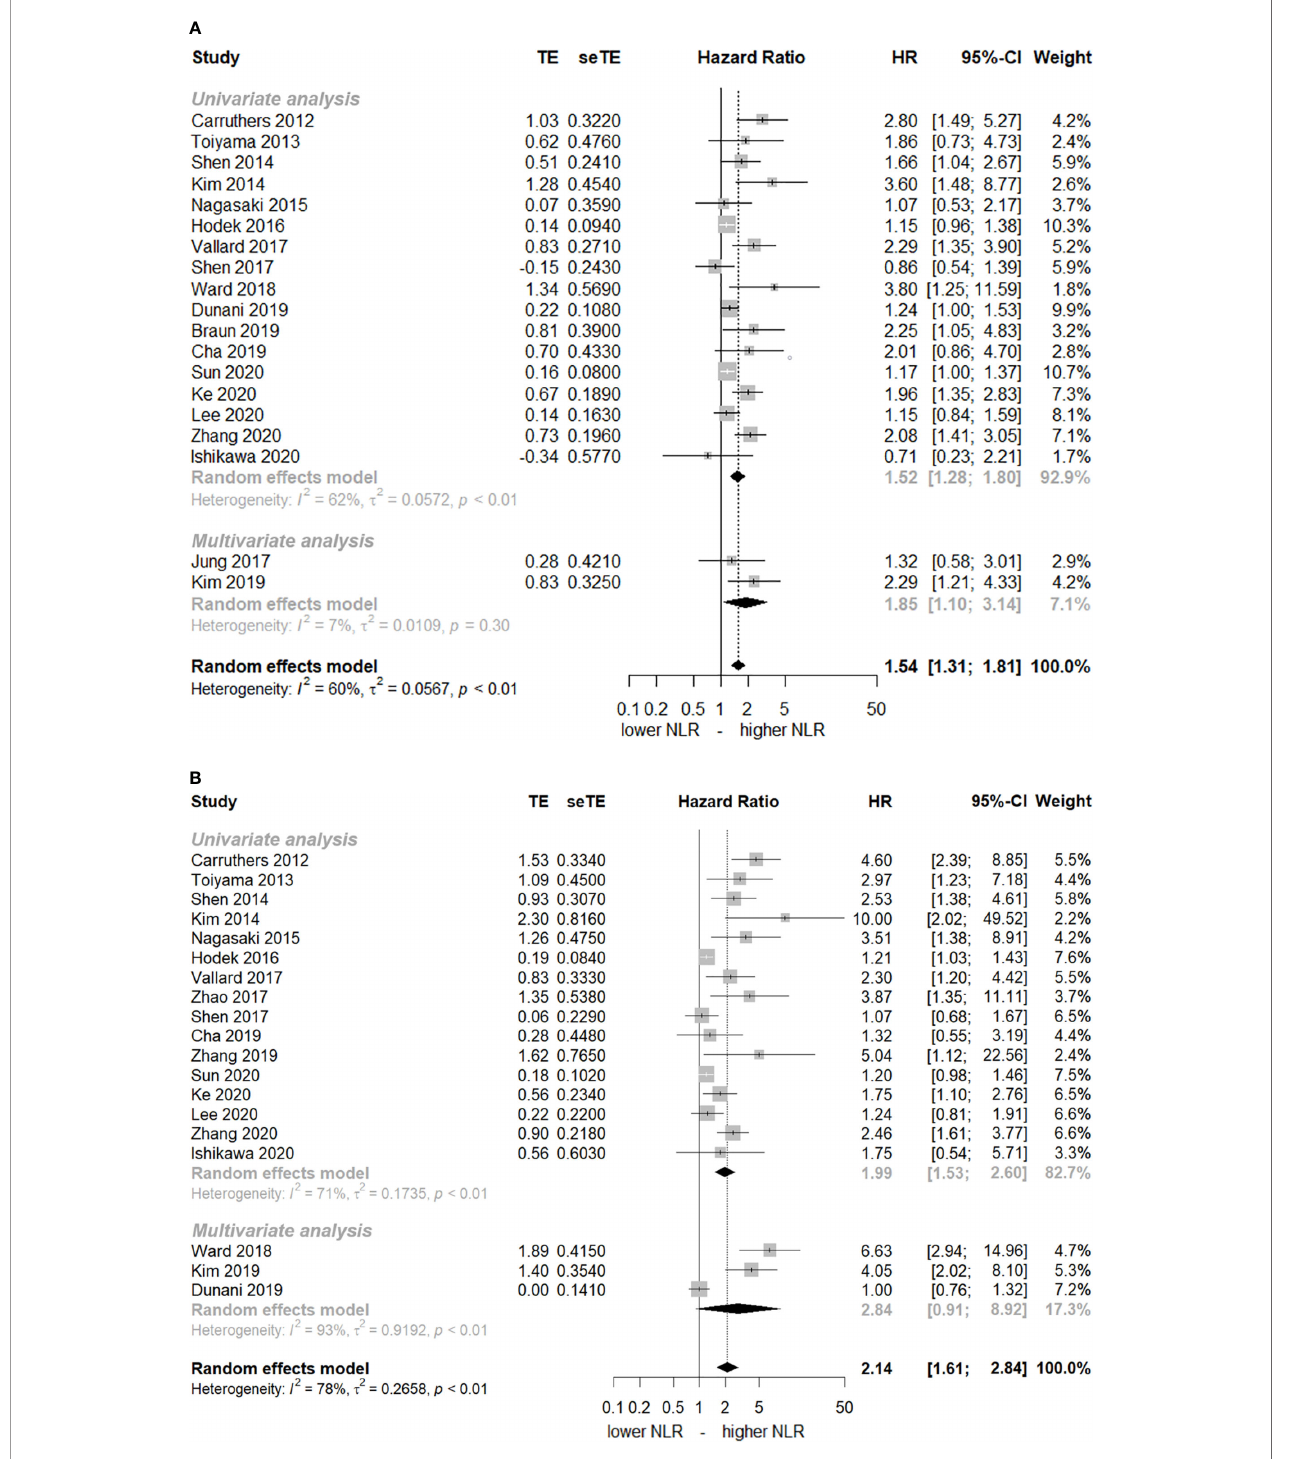
FIGURE 2 | Forest plot of hazard ratios (HR) for an elevated neutrophil-lymphocyte ratio (NLR) before chemoradiotherapy. (A) disease-free-survival and (B) overall survival. The squares represent HR for each study and their size represents the weight of the study in the meta-analysis. The horizontal lines crossing the squares represent the 95% con fi dence intervals